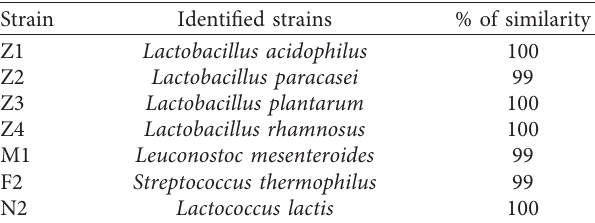
Table 2: Identification of LAB strains through 16S rRNA gene